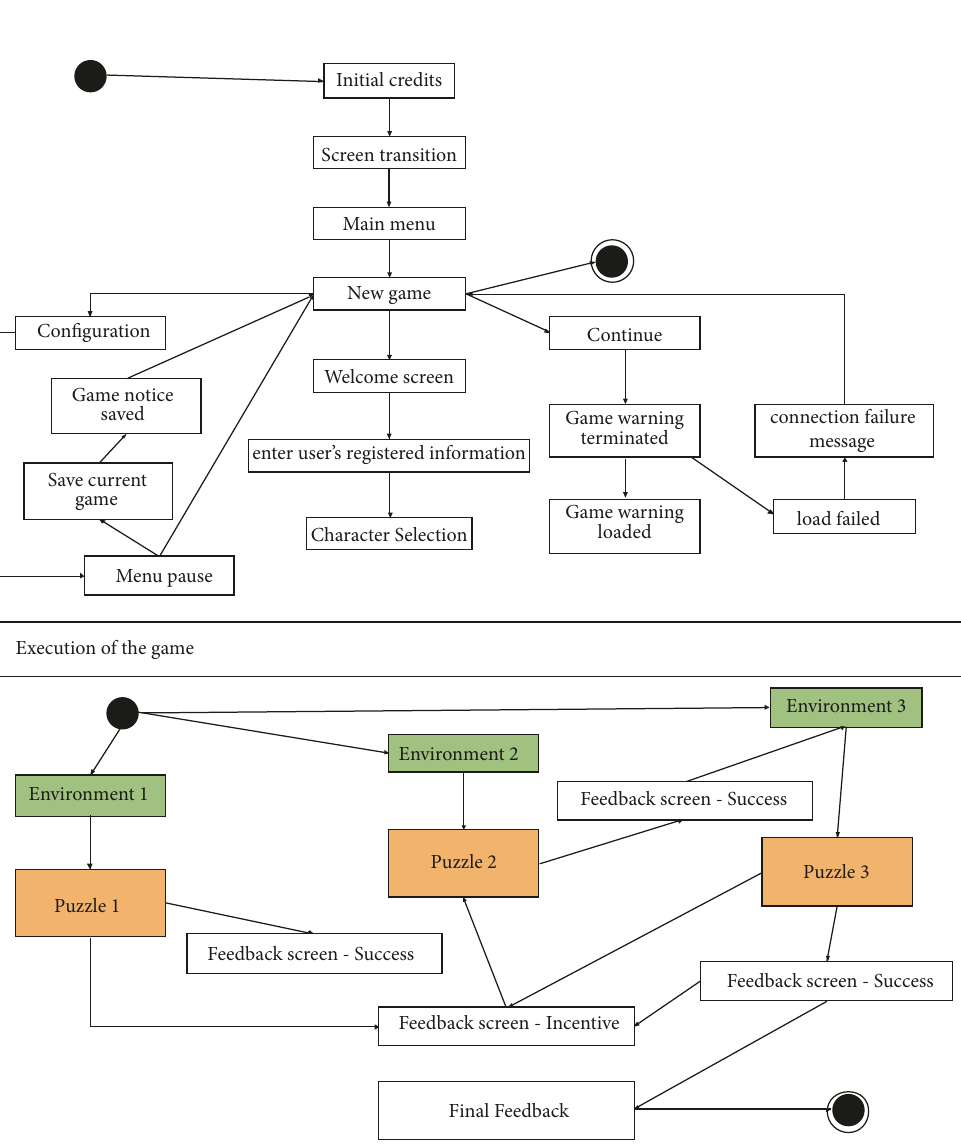
Figure 1: Use case diagram of ALTRIRAS game.